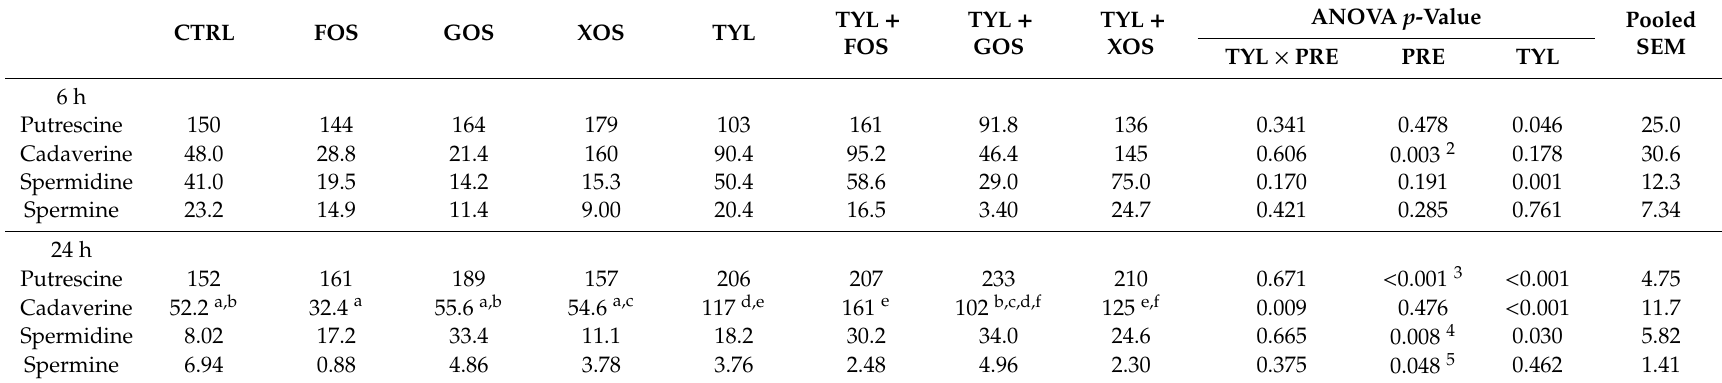
Table 3. Concentrations of biogenic amines (nmol / mL) after 6 and 24 h of an in vitro incubation of canine fecal inoculum with a control diet supplemented with some prebiotics and / or tylosin tartrate 1